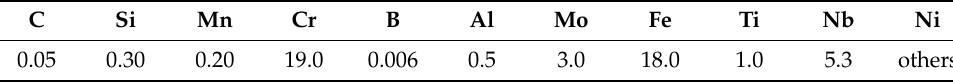
Table 1. GH4169 alloy composition (wt. %).